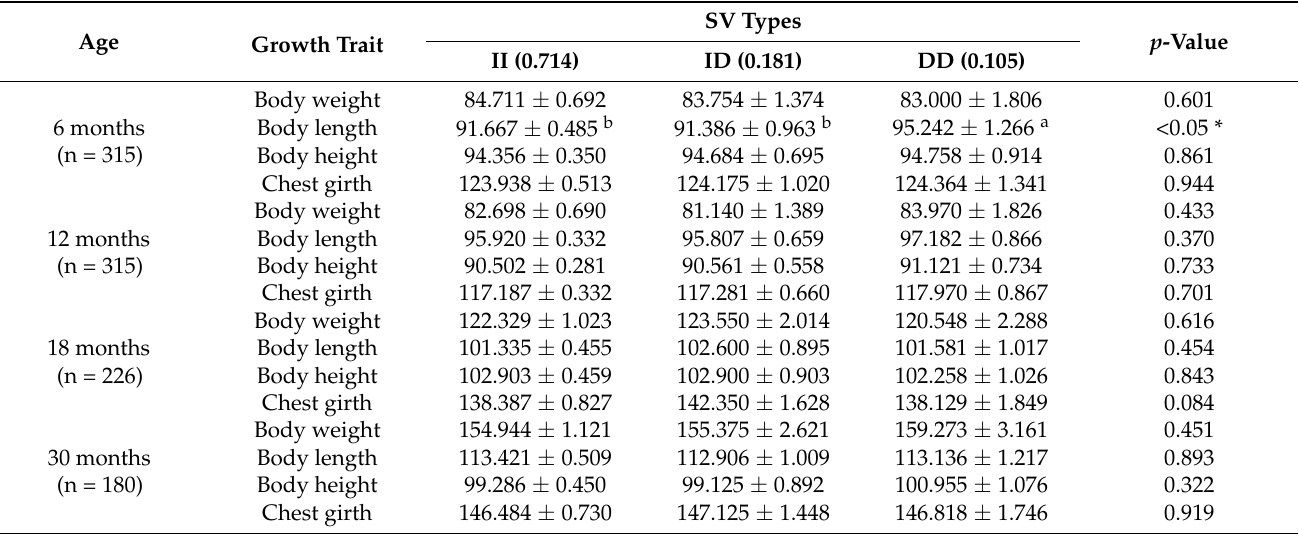
Table 4. The association analysis between different body size traits and different GHR genotypes of